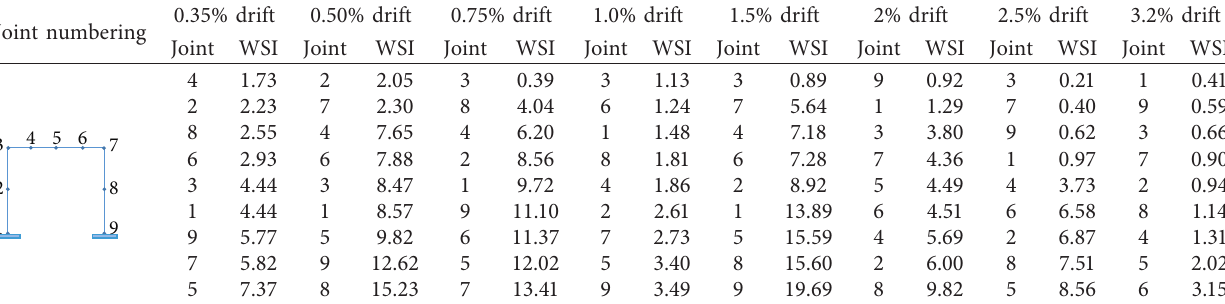
Table 4: Localization of damage with the DLV approach at each damage